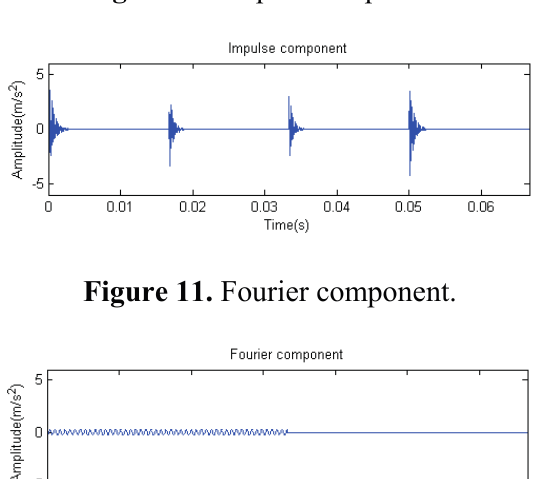
Figure 10. Impact component.